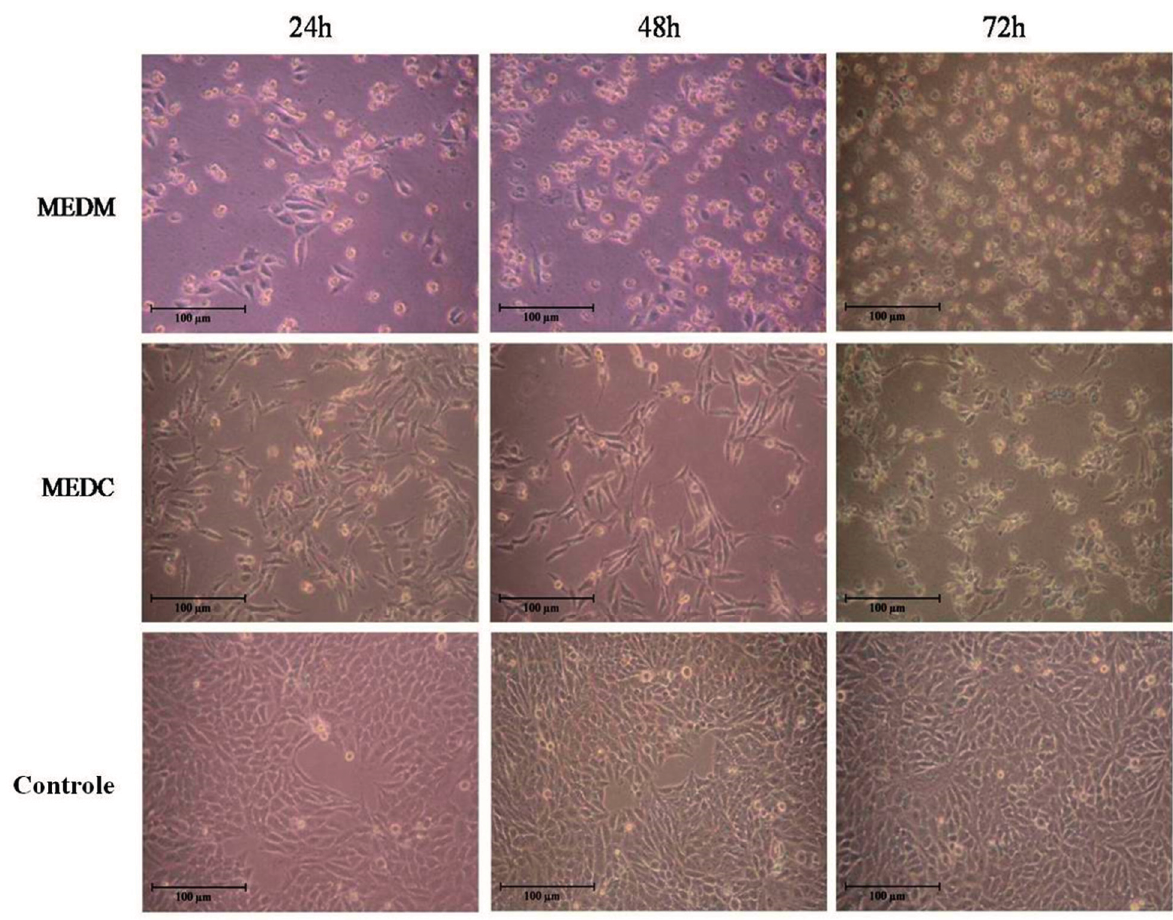
Figure 3. Morphological changes of HeLa cells after treatment with MEDM and MEDC for different times. HeLa cells were treated with extract (0.2 mg/mL) for 24 h. After